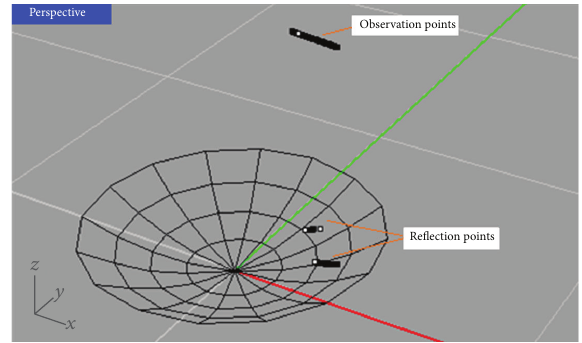
Figure 5: Perspective view of the simple reflection points obtained with function (1) or (3).